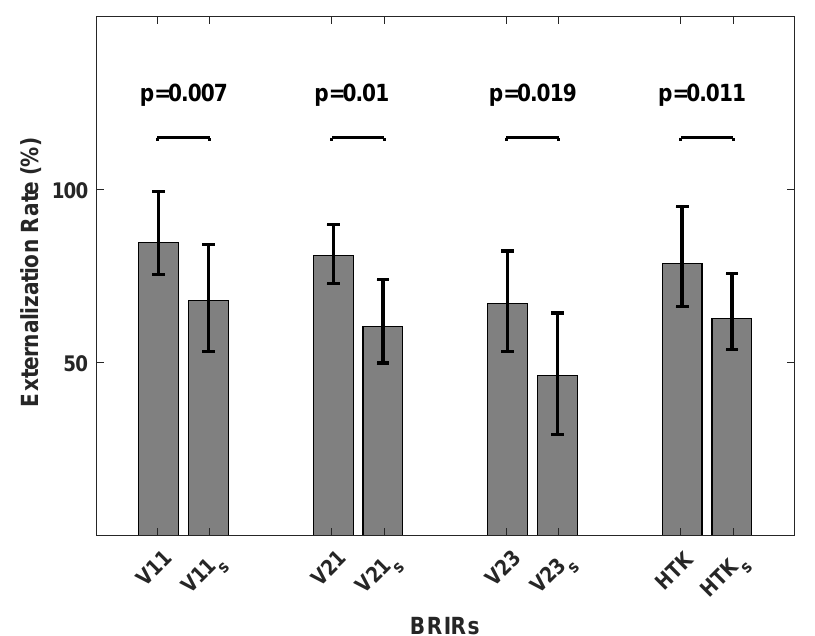
Figure 14. Externalization rate, averaged over target positions, when listening to virtual sources generated with V11, V21, V23 and HTK in TestDynamic and with V11 s , V21 s , V23 s and HTK s in TestStatic. Horizontal bars indicate significant differences (according to the Wilcoxon signed-rank test). Error bars indicate 95% confidence